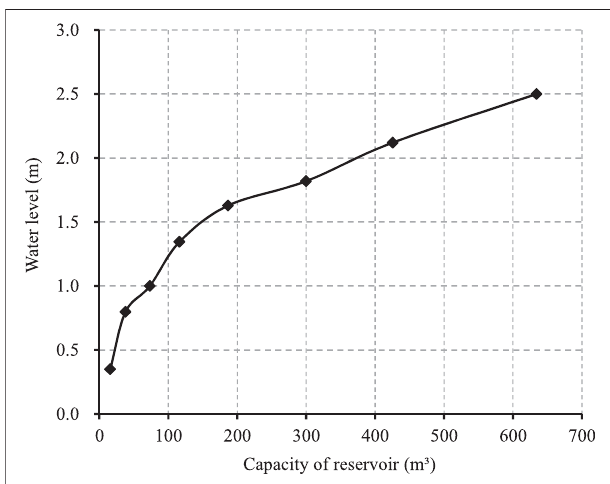
FIGURE 5 | The curve between the water level and storage capacity of the reservoir.